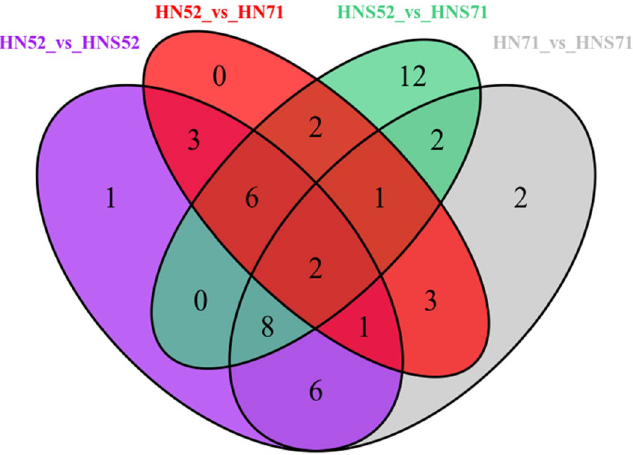
Figure 4. Venn diagram showing the relationships between different groups of metabolites.